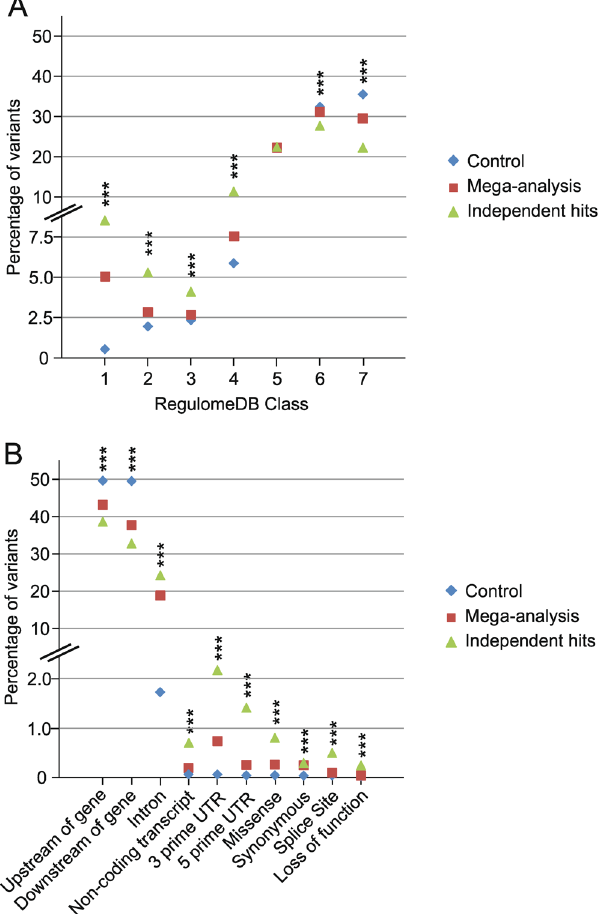
Figure 3. Functional annotations and predicted consequences of local eQTL-variants. Three sets of variants were evaluated by employing two different databases. Set one (control) includes random variants of the imputed genotype file, which are located next to at least one gene within a distance of a maximum of 1 Mb. Set two (mega-analysis) consists of all significant mega-analysis (Q-Value < 1 × 10 − 3 ) eQTL variants while the third group comprises the most significant variant of each independent hit (including the independent secondary signal variants). ( A ) The chart depicts the percentage of variants per variant set categorised into seven groups by RegulomeDB. The seven-level functional score is based on a synthesis of data derived from various sources: category 1 variants are very likely to affect binding and are linked to gene expression of a target gene (i.e. are known eQTL variants); categories 2 and 3 are likely to affect at least transcription factor binding and several other regulatory effects; categories 4–6 show minimal functional indication while category 7 variants lack evidence for any functional relevance. ( B ) The chart shows the percentage of variants classified into ten classes of consequences according to the Ensembl Variant Effect Predictor (VEP). For variant set two (mega-analysis) and three (independent hits) we only included the predicted consequence affecting the identified eQTL gene. For the control group, one random gene within a variant–gene distance of a maximum of 1 Mb was chosen. We selected the most severe effect, if the variant had different effects on transcripts of the same gene. *** P-Value for difference between groups <